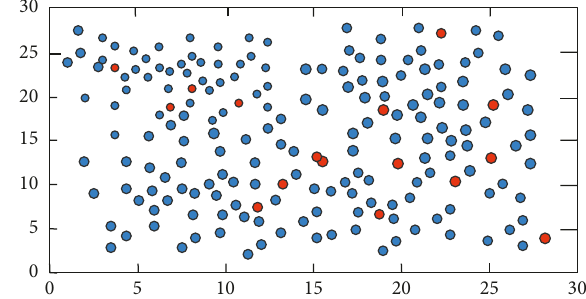
Figure 5: Outliers detected by the improved